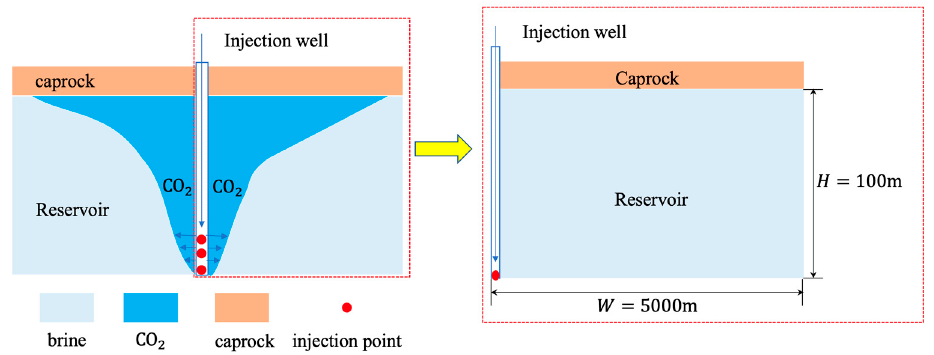
Figure 1. The conceptual model of numerical simulation.